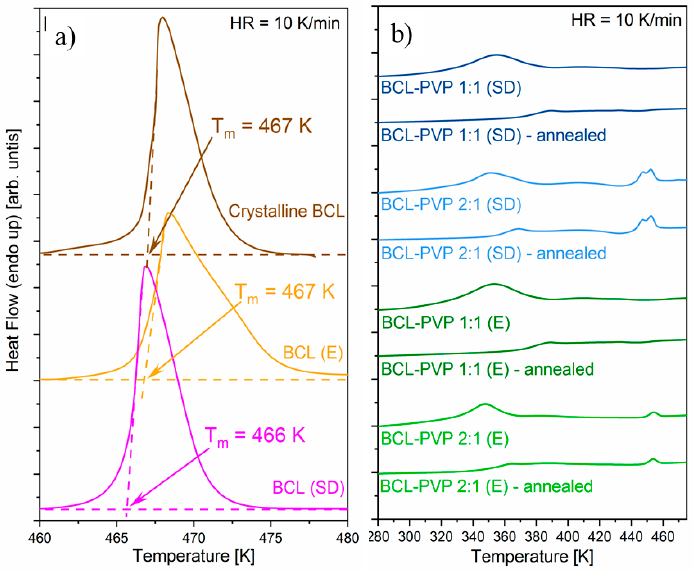
Figure 2. The DSC thermograms of binary systems containing bicalutamide alone ( a ) and BCL–PVP solid dispersions ( b ).